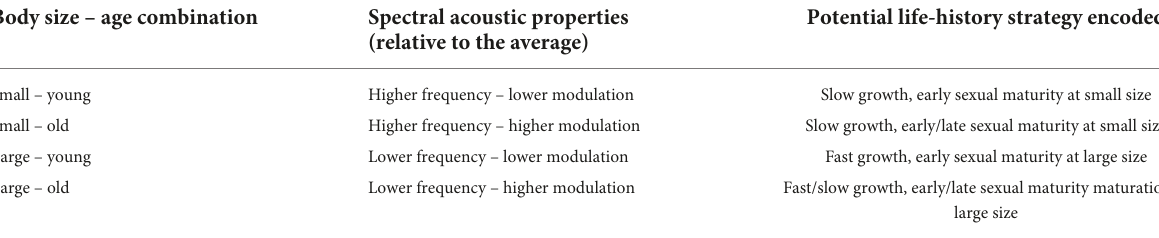
TABLE 2 Potential trait combination (i.e., body size and age) and associated life-history strategies encoded within the spectral properties of the mating calls of L. bufonius males (i.e., dominant frequency and dominant frequency modulation). Body size – age